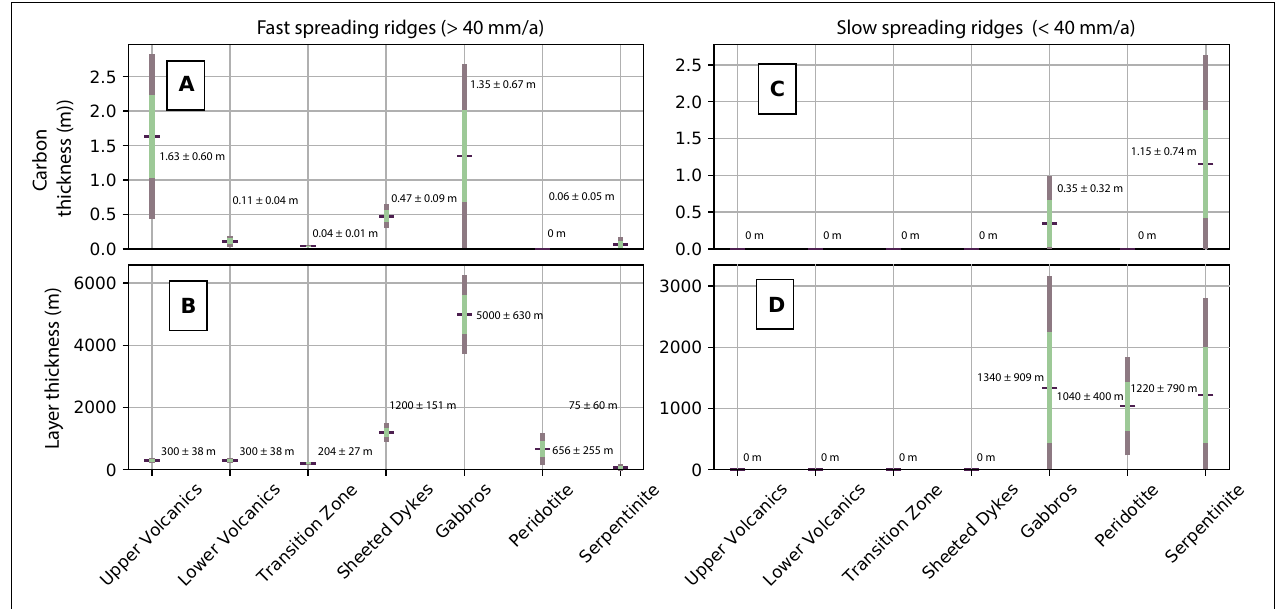
FIGURE 5 | Summary of predicted crustal and carbon storage thicknesses at fast and slow spreading ridges from our model and the carbonate values from Kelemen and Manning (2015). A spreading rate drawn randomly from the present-day distribution of global spreading rates preserved in ocean basins (37 ± 27 mm/a) is used to initiate the calculation. Using this spreading rate, we determine the thickness of the different oceanic crust components and their corresponding carbon thickness. To ensure components are adequately sampled, this process was repeated 10000 times. The average bottom water temperature of the last 400 Ma, 12 ◦ C (Müller and Dutkiewicz, 2018), was used in the calculation, meaning the thicknesses are ∼ 60% of expected thicknesses assuming warm bottom water ( ∼ 20 ◦ C). Purple shows the maximum range of values, with one standard deviation highlighted in green. Text in the panels describes the mean and one standard deviation. (A) Range of possible carbon thicknesses for each lithological unit in crust produced at fast spreading ridges. (B) Range of possible thicknesses of each lithological unit in crust produced at fast spreading ridges. (C) Range of possible carbon thicknesses for each lithological unit in crust produced at slow spreading ridges. (D) Range of possible thicknesses of each lithological unit in crust produced at slow spreading